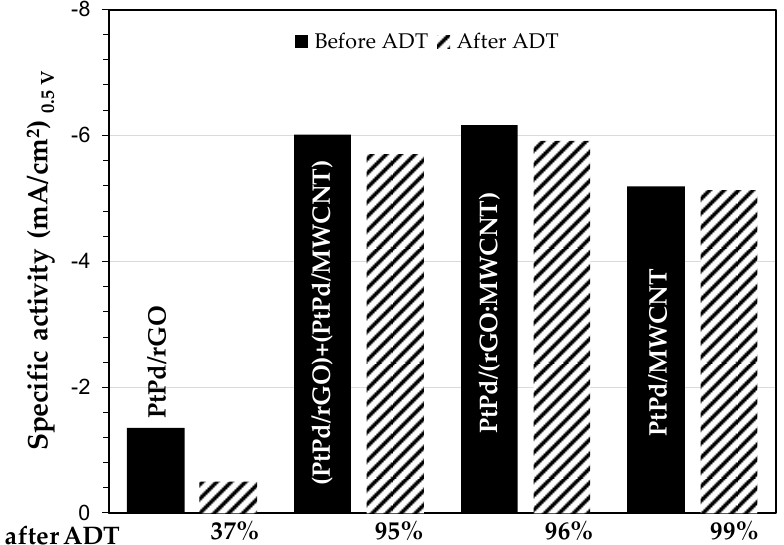
Figure 7. Stability results of bimetallic catalysts and hybrid nanocomposites.